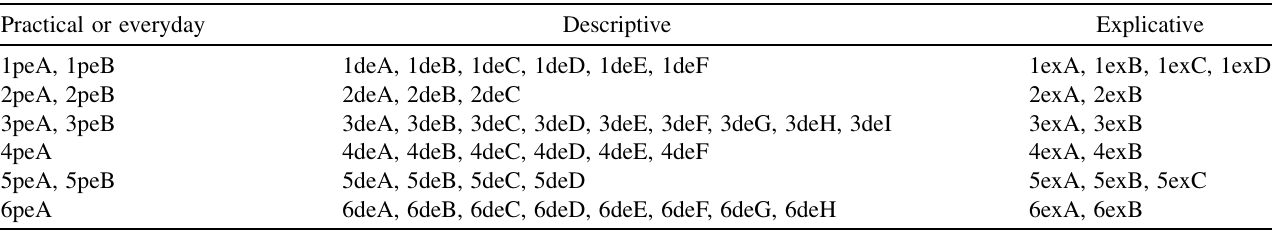
TABLE II. Ideal student profiles and related answering strategies for the six-item questionnaire. Numbers refer to the item, lowercase letters to the mental model category [practical or everyday (pe), descriptive (de), or explicative (ex)], and uppercase letters to the specific answering strategy, as shown in Appendix A.